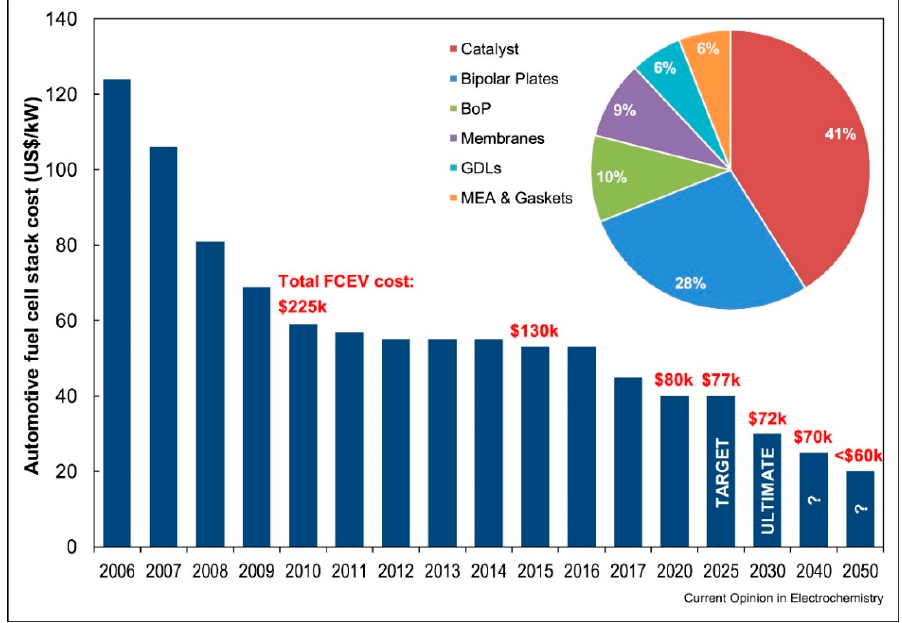
Figure 11. Evolution of automotive FC cost and projections. The PEMFC stack cost is represented by bars, the cost of the total FCEV for some years [91]. Republished with permission from Elsevier (License no: 5398690911349).